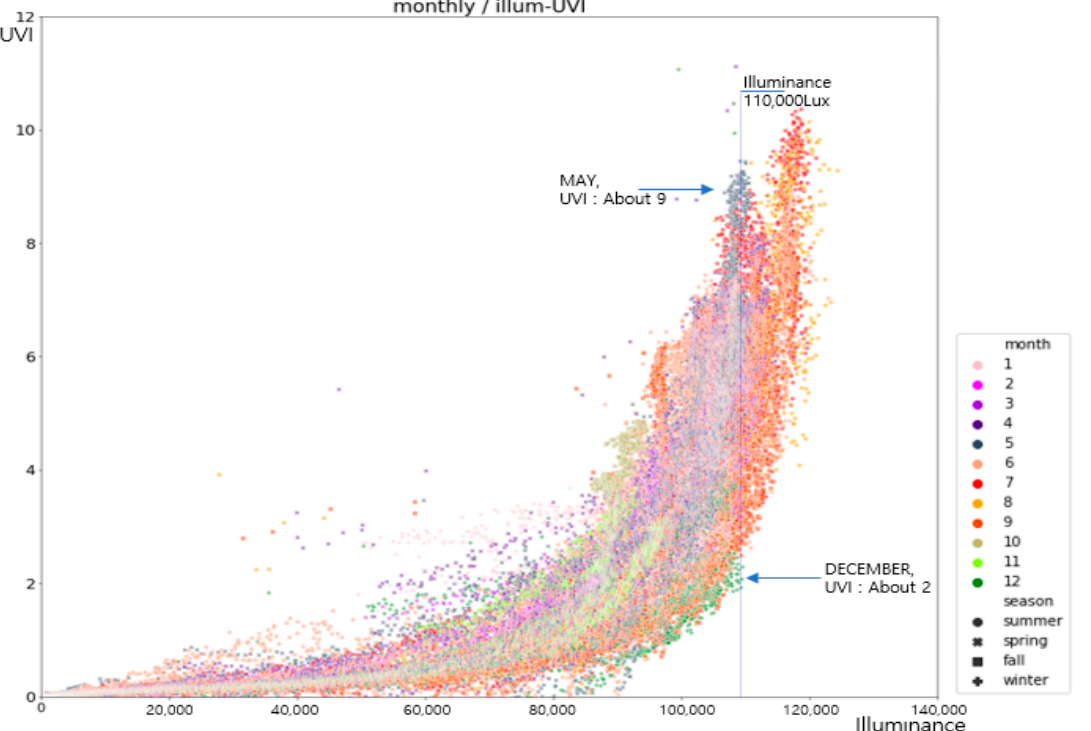
Figure 3. Monthly illumination- UVI (Ultraviolet Index) distribution characteristics. In Figure 3, the monthly illumination and UVI at the measurement location of the natural light (Cheonan, Korea) shows that as the illumination was increased, the UVI was also increased, in general. In the figure, the annual maximum illuminance was about 120,000 lux and the annual maximum UVI was 12 or higher. In addition, the UVI was higher during the relatively warm seasons (May–July), and it was low during the cold seasons (November–January). Specifically, the comparison results of the maximum UVI values in the same illuminance (110,000 lux) showed that the UVI was about 2 in Decem- ber and it was about 9 in May, exhibiting a prominent difference of the UVI by month (season) even if the same illuminance was measured. The monthly maximum UVI values were extracted for 1:00 p.m. during the noon-afternoon where the UV index was expected to be the maximum and the correlation between the illuminance and the UVI was calcu- lated according to Pearson’s correlation coefficient. The results are arranged in Table 1. Table 1. Pearson’s correlation between the monthly average illuminances and the UVI (Ultraviolet Index). Month